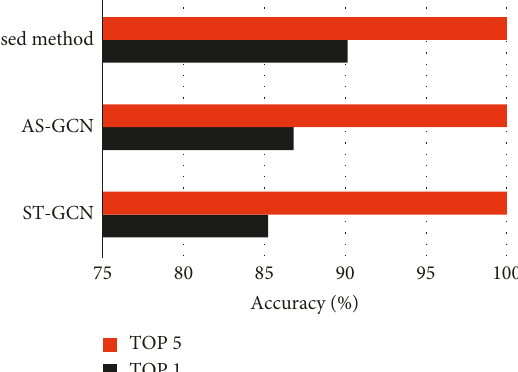
Figure 7: Comparison.